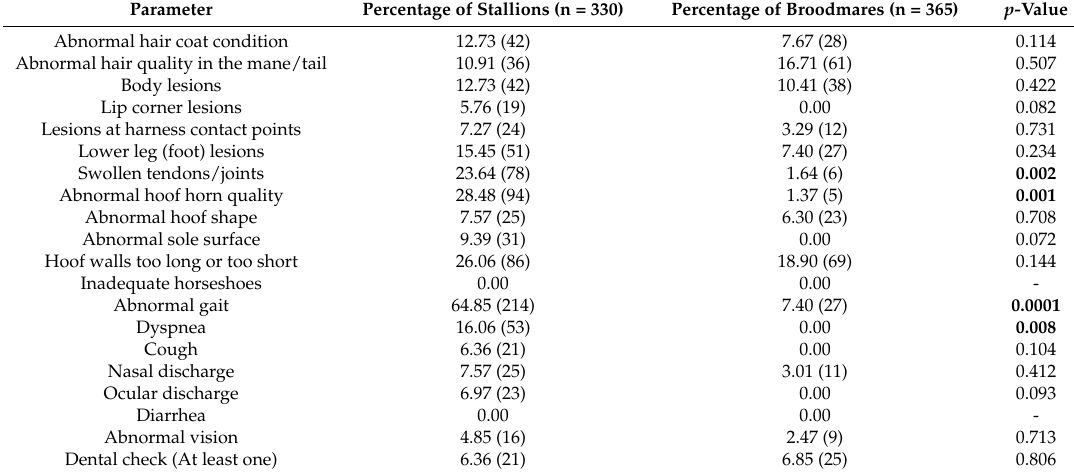
Table 4. The prevalence of health parameters assessed in each breeding horse category.